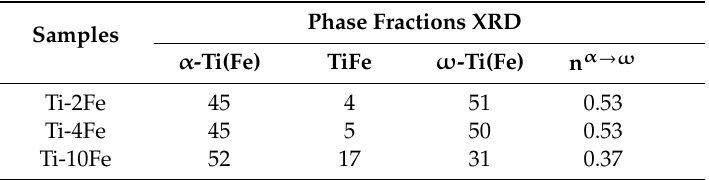
Table 2. Phase fractions (wt.%) in HPT-deformed samples, as determined using XRD. n α → ω = ω / ( α + ω ) is the fraction of α -Ti, which transformed to ω -Ti(Fe). The errors of the XRD phase analysis (1% to 3%) were estimated based on the goodness of